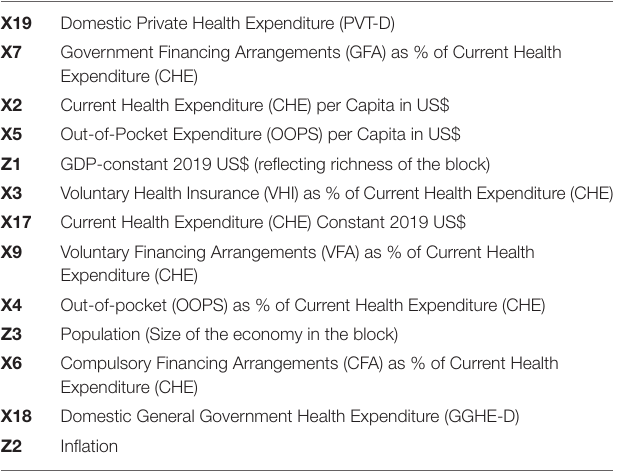
Predictors are arranged in decreasing order of importance for UHC coverage.